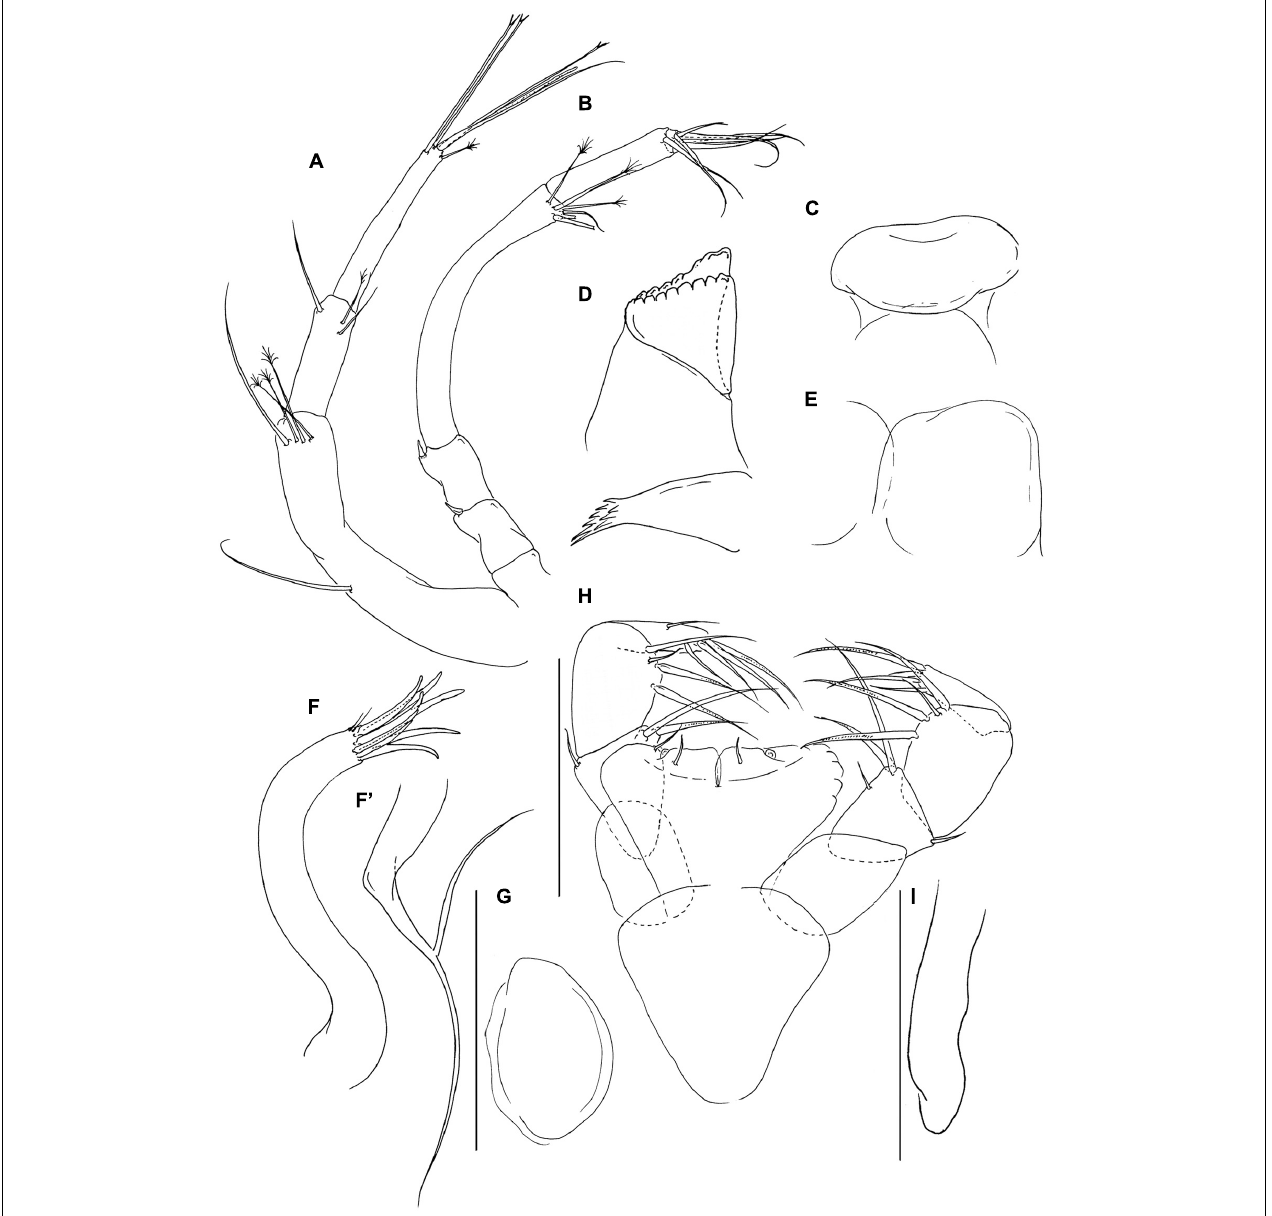
FIGURE 2 | Pseudotanais chardonnayi sp. nov; neuter (J61515), (A) , antennule; (B) , antenna; (C) , labrum; (D) , left mandible; (E) , labium; (F) , maxillule; (F’) maxillule endite; (G) , maxilla; (H) , maxilliped; (I) , epignath. Scale lines = 0.1